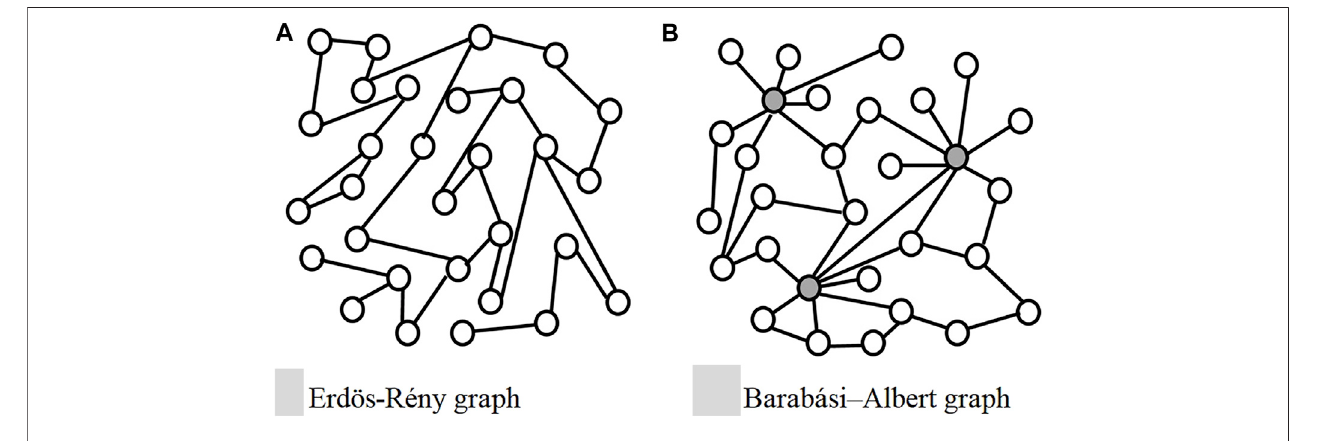
FIGURE 3 | ER and BA